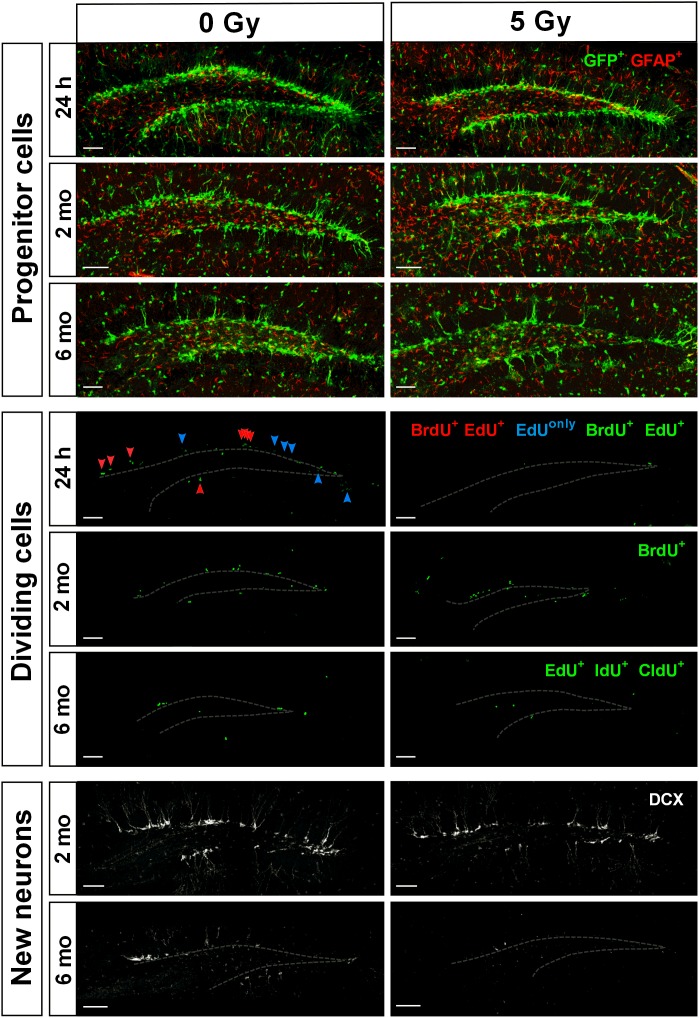
Maintenance of SGZ neural progenitors at 1 day, 2 months, and 6 months post-irradiation with 5 Gy dose. Upper three rows show Nestin-GFP-positive progenitors in the SGZ. Next three rows show dividing cells labeled according to the protocols described in Figures 1A, 5A, 7A. Green color is used for all injected nucleotides. In the fourth row, BrdU+ cells representing cells that were in S phase by the time of irradiation (parameter [a]; see text for details); EdU+ cells representing cells that were in S phase by the time of perfusion (parameter [b]); BrdU+EdU+ double-labeled cells (red arrowheads) representing cells that were in S phase by the time of irradiation and also by the time of perfusion (parameter [c]); EdUonly (i.e., BrdU–EdU+) cells (blue arrowheads) representing cells that were in S phase by the time of perfusion but not by the time of irradiation (parameter [d]). Two lower rows represent DCX-positive neurons. Gray dashed line outlines the inner border of SGZ. Scale bars show 100 μm.